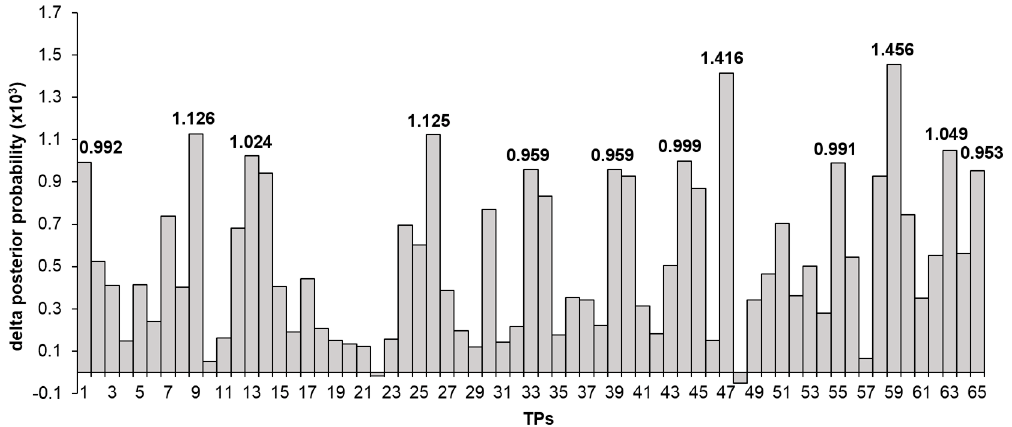
Figure 9. Histogram representing the most influential training points (TPs), corresponding to the peaks highlighted by the highest values of the delta post probability.